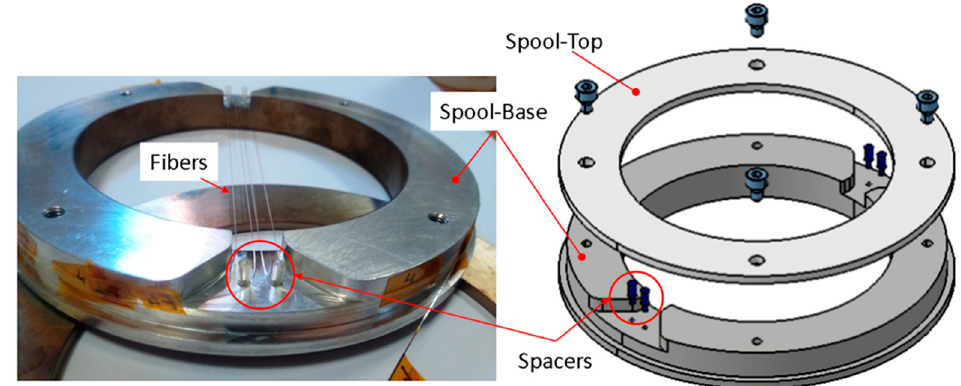
Figure 1. Fiber spool that is utilized for the gilding of the fi ber segment via spu tt ering.